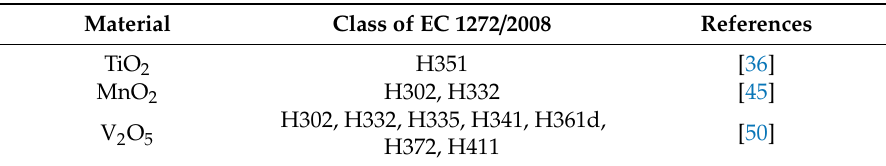
Table 2. Hazard statements related to TiO 2 , MnO 2 , and V 2 O 5